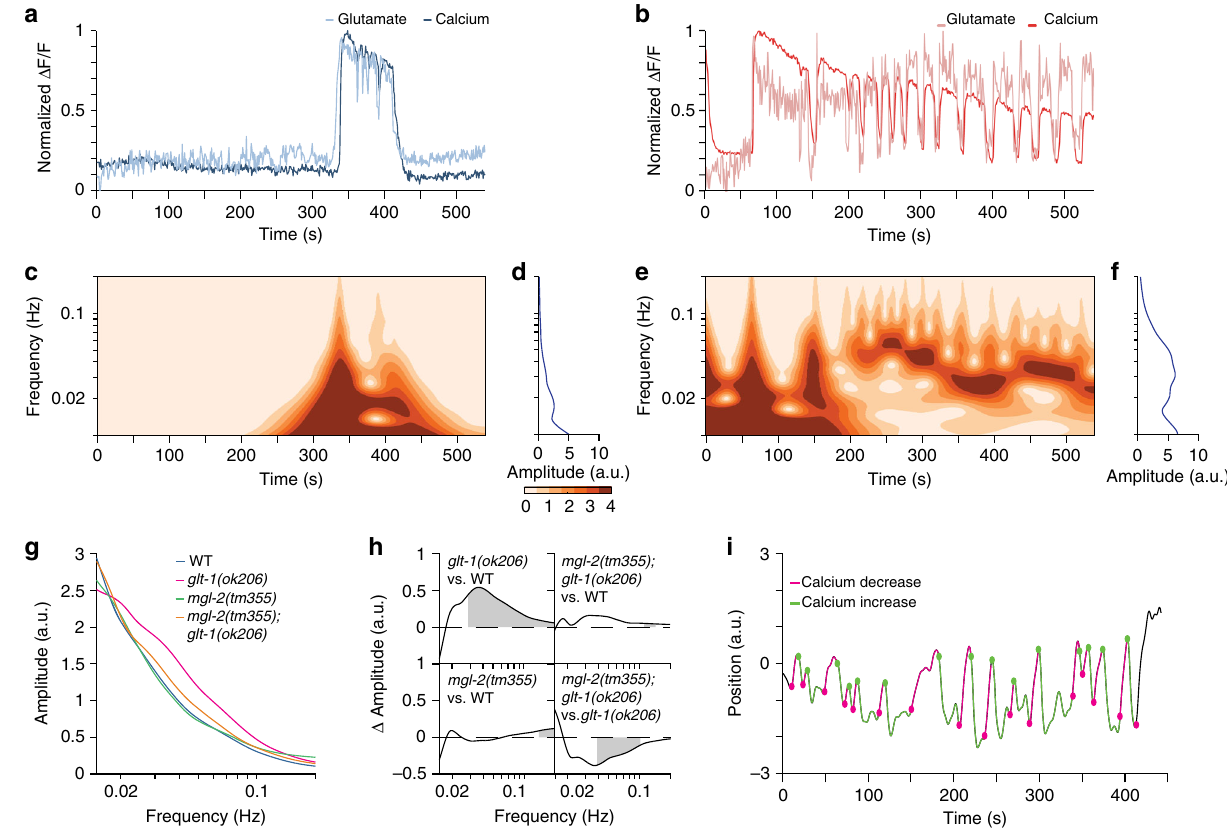
Fig. 4 GLT-1 inhibits MGL-2-dependent oscillations in glutamate secretion and AVA activation. a Representative traces of spontaneous glutamate (light blue) and calcium (dark blue) dynamics near and in a wild-type AVA neuron, respectively. b As in ( a ), glt-1(ok206) mutant (glutamate, light red; calcium, dark red). c Time-dependent frequency spectrum of calcium traces of the wild-type animal in ( a ). d Time-averaged frequency amplitudes from the wavelet spectrum in ( c ). e , f As in ( c , d ), glt-1(ok206) mutant. g Mean time-averaged frequency amplitudes for WT (blue line; 20 traces), glt-1(ok206) (magenta line; 22 traces), mgl-2(tm355) (green line; 15 traces) and glt-1(ok206) ; mgl-2(tm355) (orange line; 17 traces). h Frequency amplitude differences between indicated strain pairs. Shading, areas of signi fi cant difference p < 0.05, permutation test from bootstrapped ensembles, n = 10 4 bootstrap samples. i Representative trace of head motion in nonparalyzed glt-1 mutant animal between forward (positive) and backward (negative) positions. Traces are decorated in green, magenta for increased, decreased calcium signals, respectively. Circles, transition points. Source data are provided as a Source Data fi